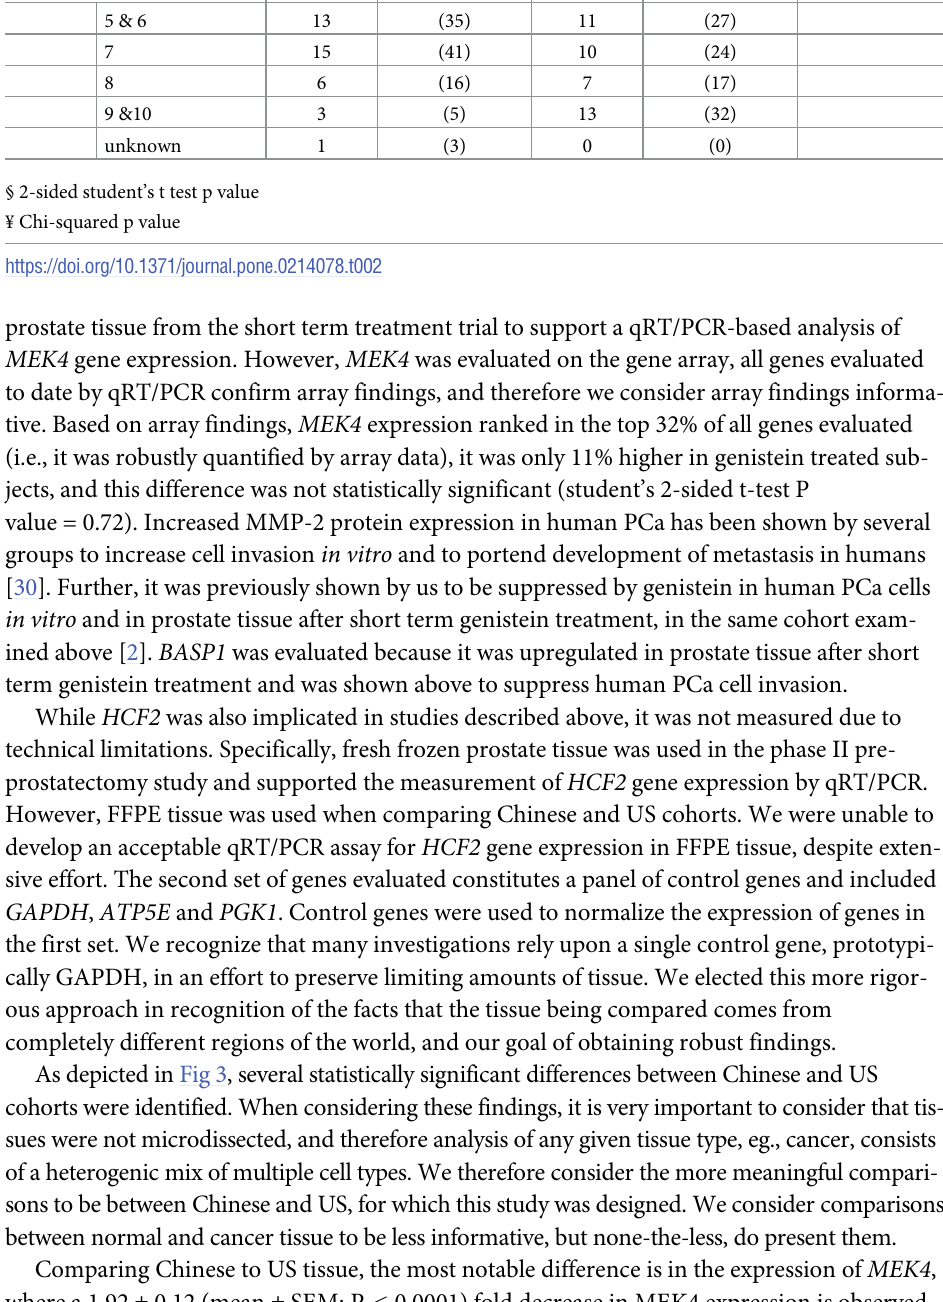
Gleason score, No.